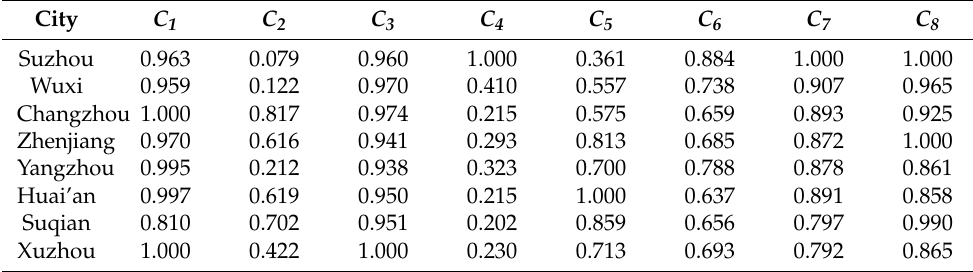
Table 10. Results of standardised processing of 2019 indicator